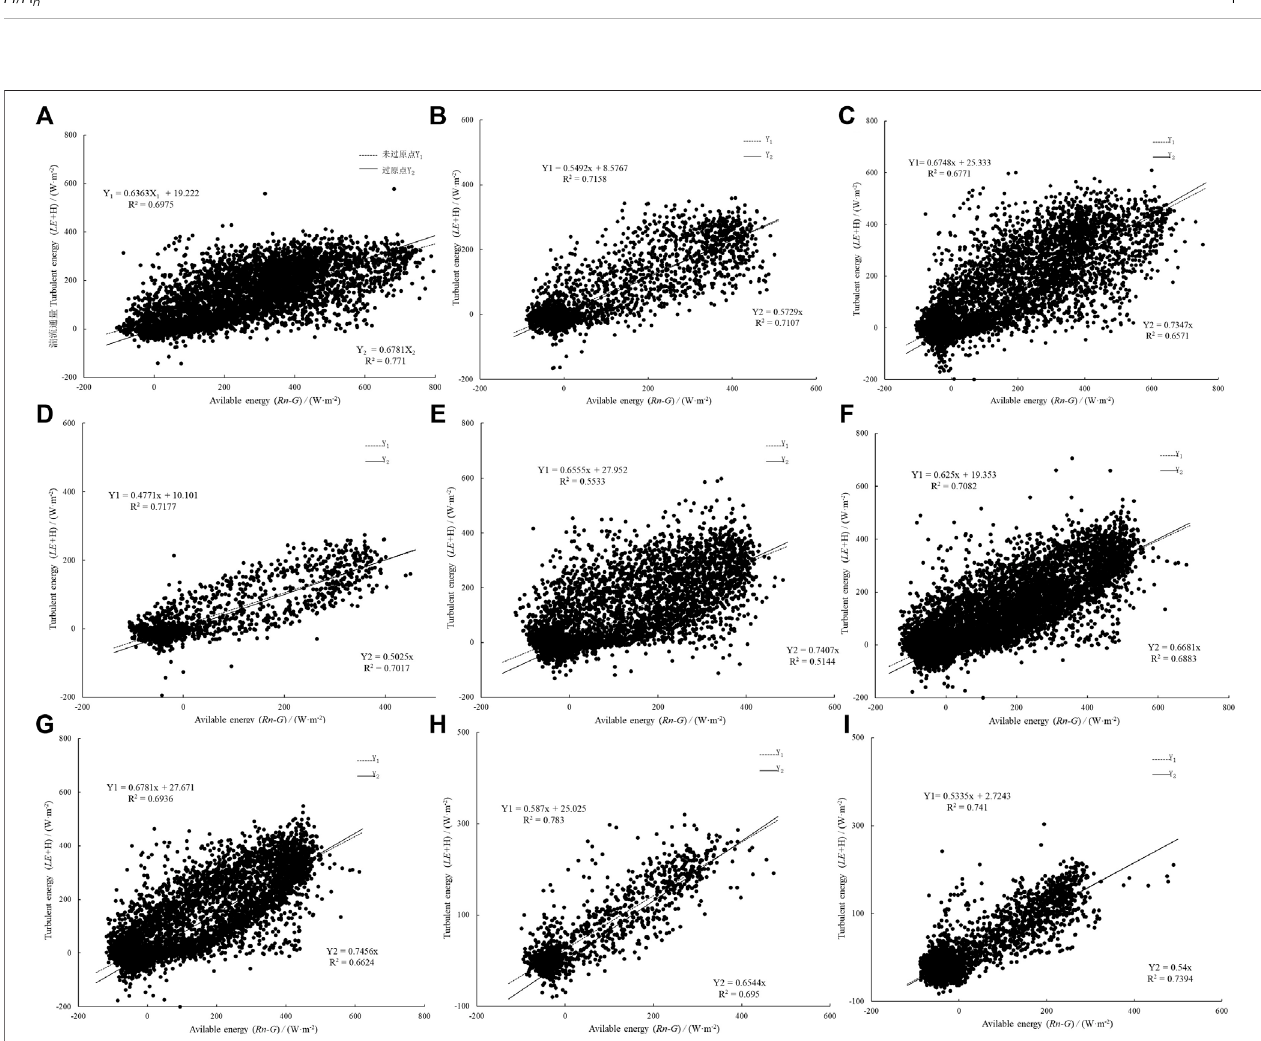
FIGURE7 | Relationship between energy turbulent fl ux ( H + LE ) and effective energy ( Rn − G ) in different periods under the half-hour data set. (A) 2019; (B) Pre-growth period in 2019; (C) Growth period in 2019; (D) Declining period in 2019; (E) Growth period in 2020; (F) 2021; (G) Growth period in 2021; (H) Declining period in 2020; (I) Freezing period in 2020.